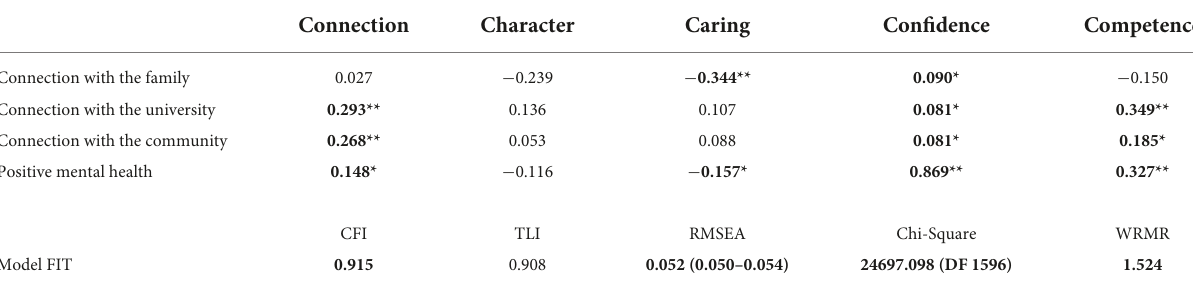
TABLE 2 Results of confirmatory factor